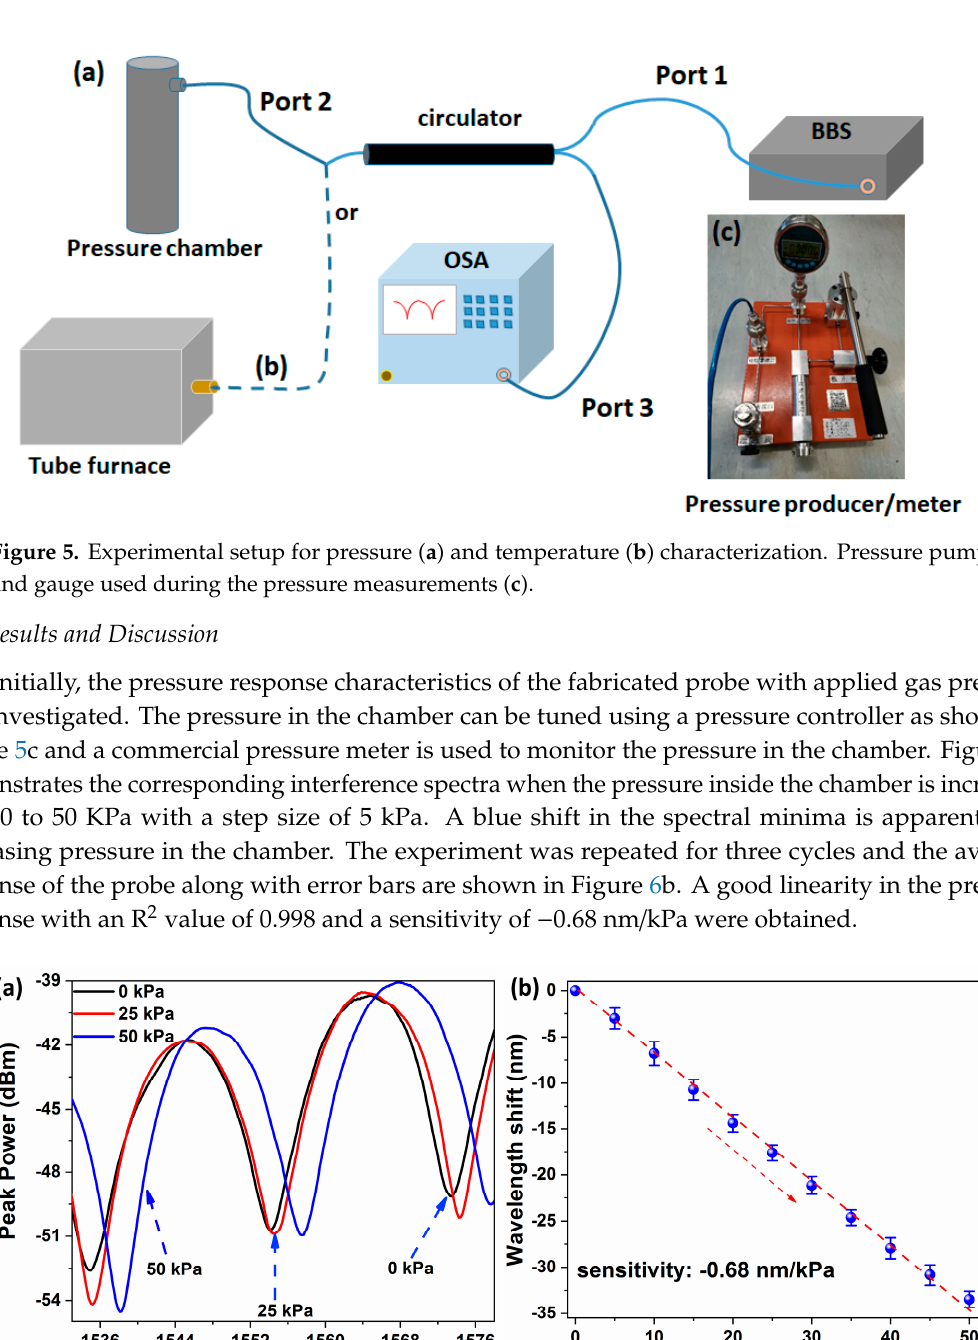
Table 1. Gas-pressure sensitivities of several fiber-optic FPI sensors.